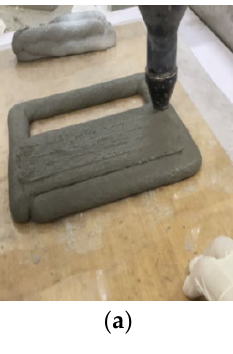
Figure 3. Preparation process of the 3D printed axial tension specimen. ( a ) Specimen printing; ( b ) Specimen is printed and formed; ( c ) Specimen cutting; ( d ) Specimen preservation.